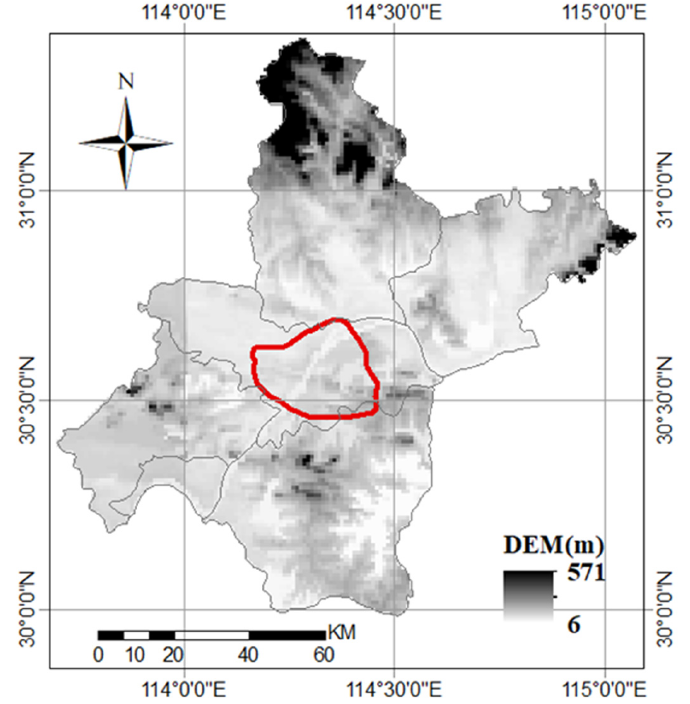
Figure 1. The map of the Wuhan city; the red line is the third ring road of Wuhan.